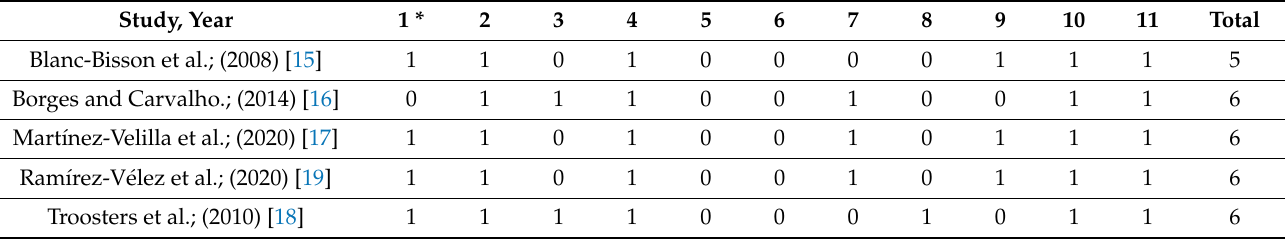
Table 3. Assessment risk of bias (PEDro scale).